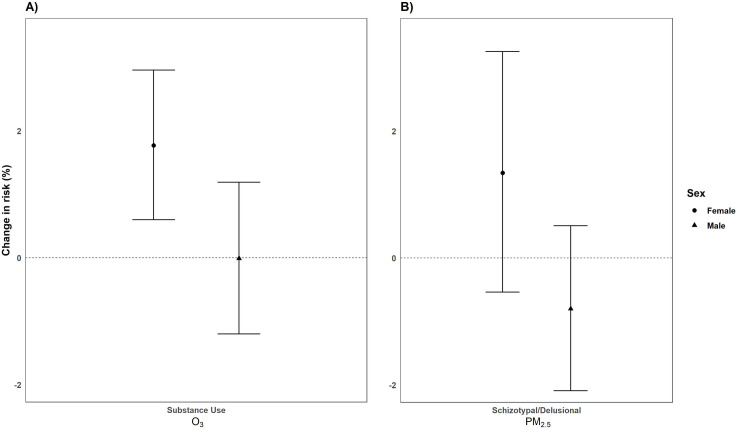
Percentage change (95% CI) in the risk of ED visits for O3 (per 10 ppb increase) (A) and PM2.5 (per 10μg/m3 increase) (B) by gender from 2005–2013 in California.1 Bars: 95% Confidence Interval; CI: Confidence Interval; ED: Emergency Department; ppb: parts per billion. 1Only significant outcomes shown.